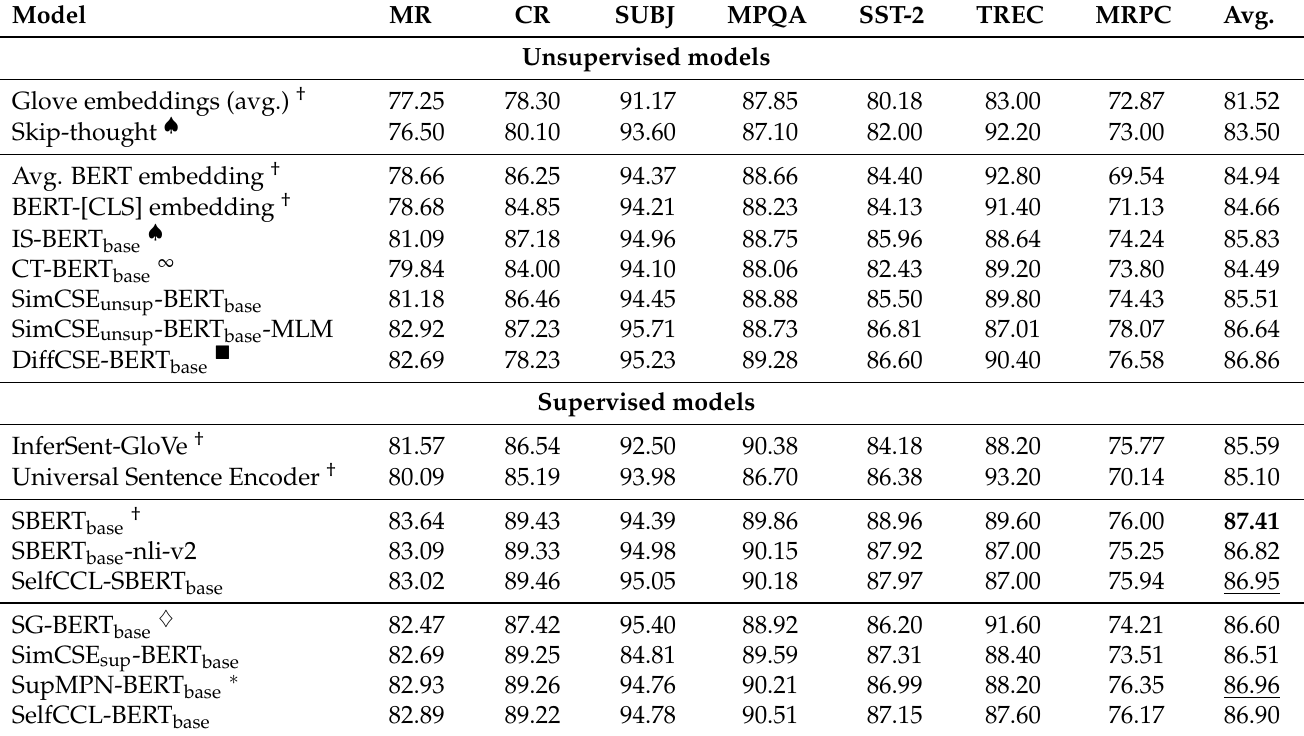
Table 5. Assessment results for the seven transfer learning tasks. The prediction accuracy is given for each task in the columns. The best average result is in bold in the last column. †: [33], ♠ : [6], ♦ : [8], ∞ : [11],